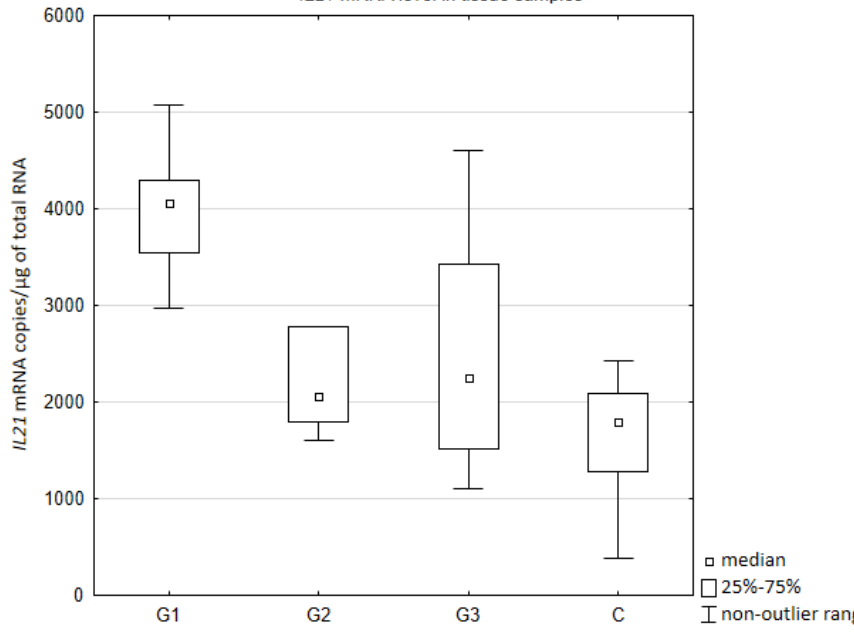
Figure 1. Number of copies of IL21 mRNA/ µ g of total RNA in tissue samples depending on the degree of ovarian cancer differentiation G1 (well differentiated), G2 (moderately differentiated), G3 (poorly differentiated) compared to the control group (C).